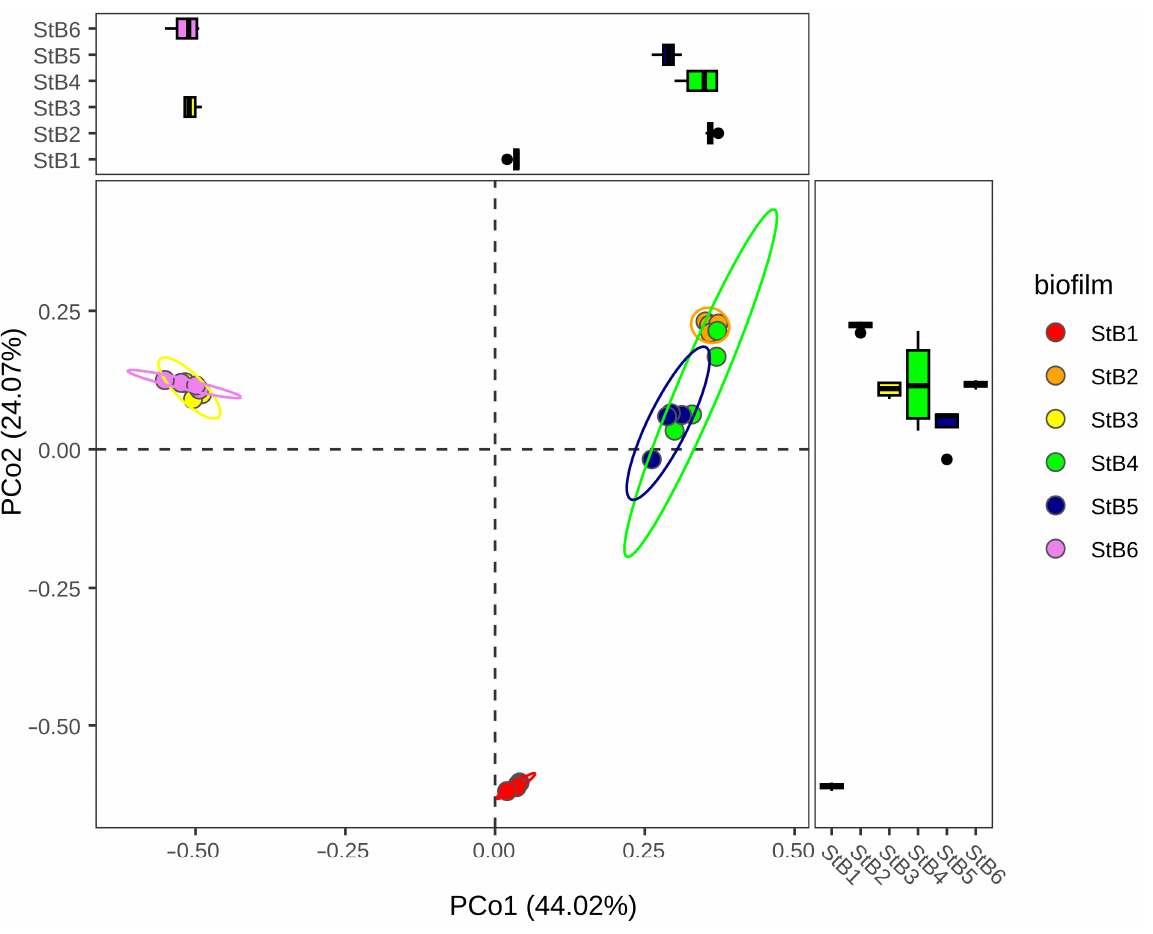
Figure 3. Results of principal coordinates analysis (PCoA) of the biofilm-forming bacterial communities based on the Bray–Curtis distance.